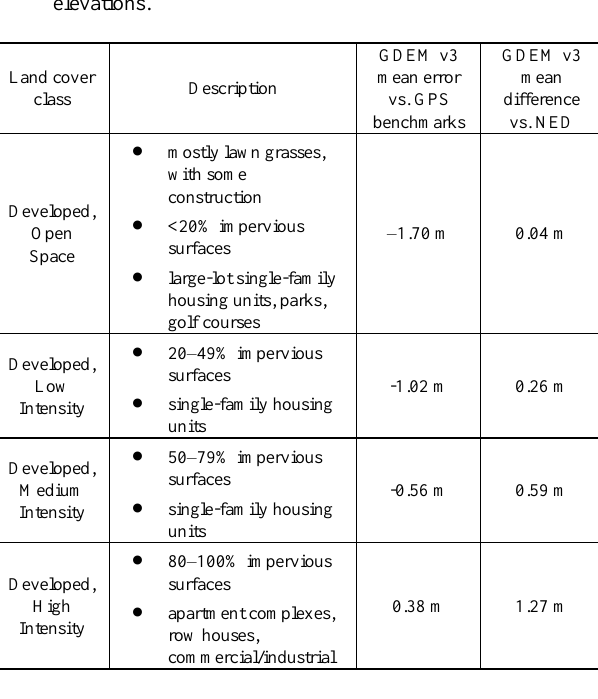
Table 2. Increasing GDEM v3 mean error with increasing density of developed land cover.